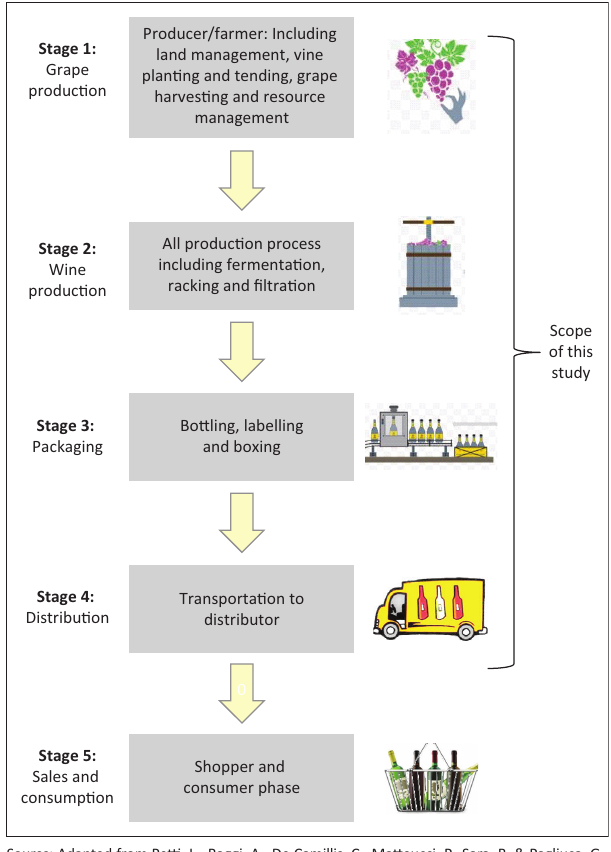
FIGURE 2: An illustration of the basic wine supply